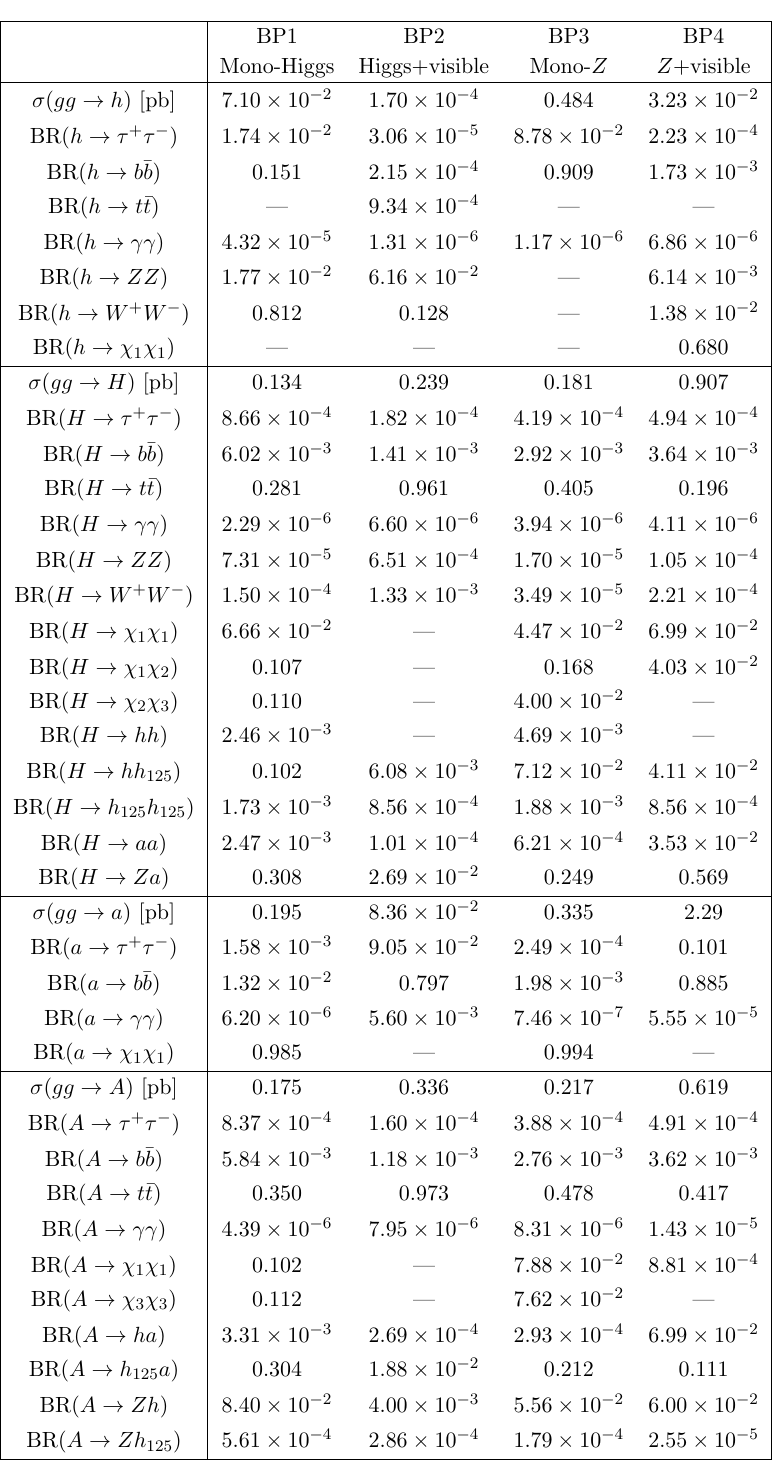
p s = 13 TeV LHC, (cid:27) ( gg ! (cid:8)), as well